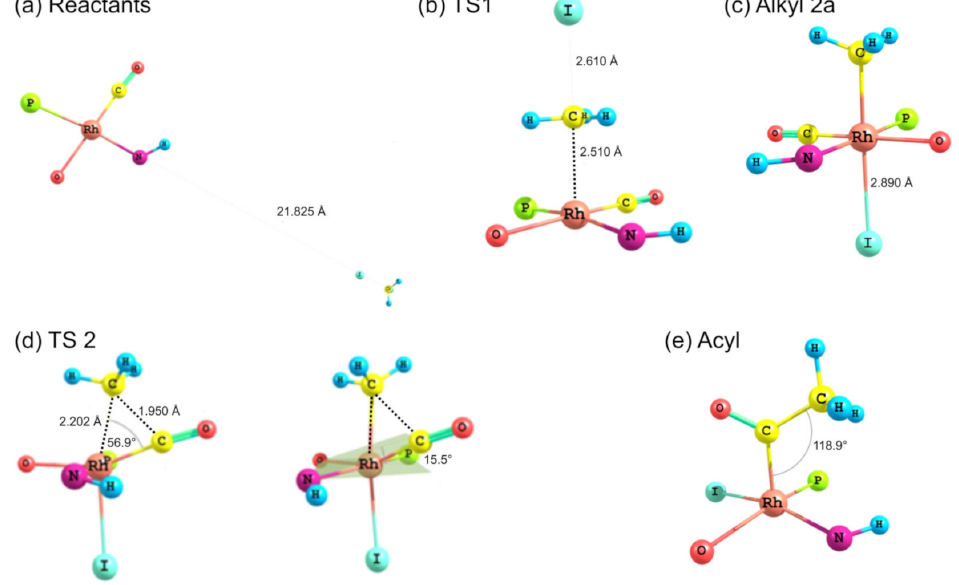
Figure 9. ( a ) DFT-calculated optimized geometries of the [Rh(CH 3 COCHCNHCH 3 )(CO)(PPh 3 )] 3A (isomer O- trans -CO) complex and CH 3 I with a large separation between the reactant molecules, referred to as Reactants. ( b ) DFT-calculated optimized geometry of the linear oxidative addition reaction between the [Rh(CH 3 COCHCNHCH 3 )(CO)(PPh 3 )] 3A and CH 3 I. The methyl group of the CH 3 I moves towards the Rh metal centre in order to form a bond and the distance between the methyl group and the I atom increases, referred to as TS1. ( c ) DFT-calculated optimized geometry of the Rh(III)-alkyl 2a product formed during step 1, referred to as Alkyl-2a. ( d ) Left: Geometry of the DFT-calculated transition state of the methyl migration towards the CO group in the formation of the [Rh(CH 3 COCHCNHCH 3 )(CO)(PPh 3 )] 3A acyl 14a product. Right: Deviation of the CO group from the square planar geometry, referred to as TS2. ( e ) DFT-calculated optimized geometry of the [Rh(CH 3 COCHCNHCH 3 )(CO)(PPh 3 )]-acyl product, after the migration of the methyl group towards the CO group, referred to as Acyl. The three Ph groups of the PPh 3 ligand and CH 3 CCHCCH 3 backbone of [CH 3 COCHCNHCH 3 ] ligand were excluded for clarity. The bonds associated with the imaginary frequency of TS1 and TS2 are indicated with black dotted